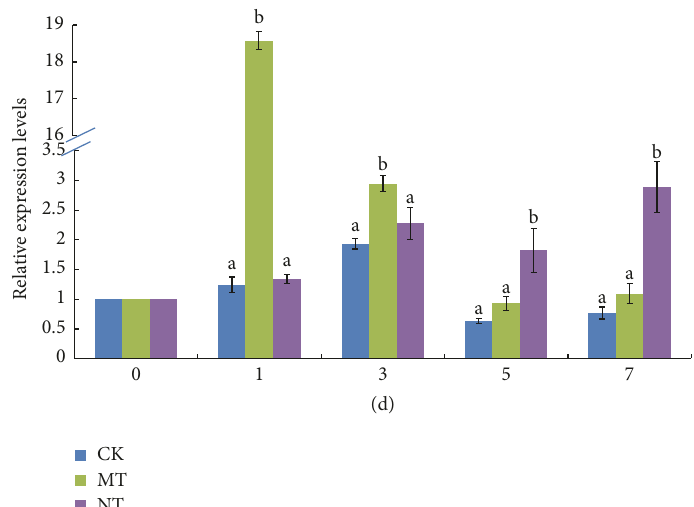
Figure 5: Expression profile by qRT-PCR with 1-MCP and NO treatments (CK: control group; MT: 1-MCP treatment; NT: nitric oxide (NO) treatment). (a and b) Differences between experimental treatments that were performed with the SPSS 20.0 software.